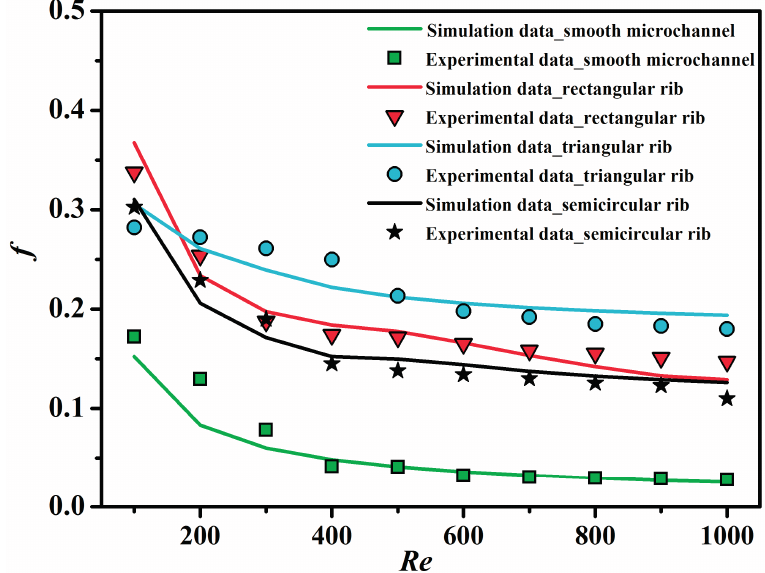
Figure 10. The apparent friction factor as a function of the Reynolds number for all ribbed and smooth